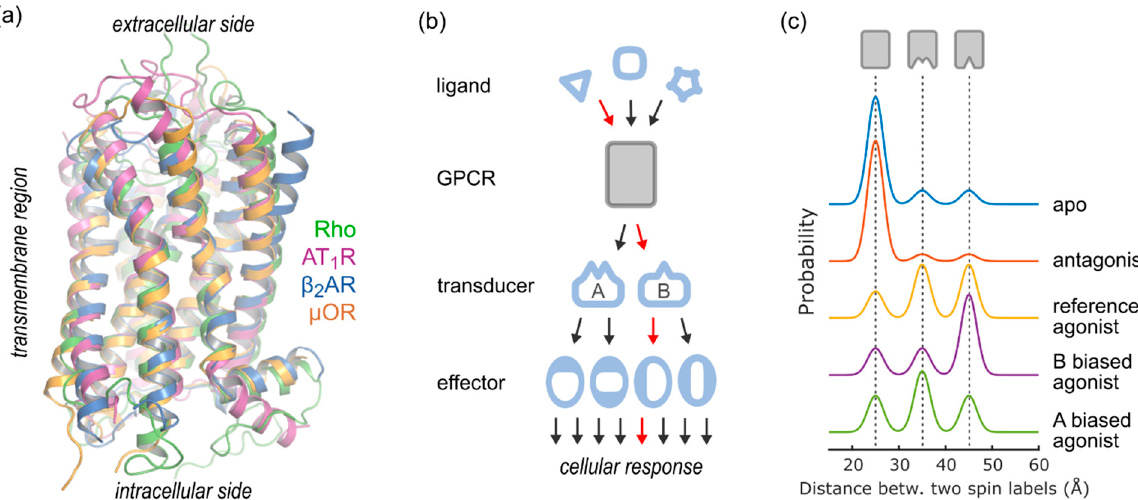
Figure 1. GPCR function seen from the DEER vantage point. ( a ) Structural homology among GPCRs of various functions. Receptor-specific ligands bind from the extracellular side, which therefore shows high structural diversity between different receptors. The transmembrane core exhibits many conserved interaction networks, suggesting a common activation mechanism. On the intracellular side, a limited set of transducer proteins (such as G protein, arrestin and GRK) bind to specific receptor conformations. ( b ) The GPCR “allosteric microprocessor”. Binding of an extracellular ligand is translated into ligand- and receptor-specific affinities and catalytic activities towards transducer proteins. Activated transducer proteins interact with different effectors and thereby elicit a ligand-specific cellular response. ( c ) Conformational selection from the DEER perspective. Different ligand classes (such as antagonists, balanced/reference and biased agonists) stabilize distinct GPCR conformations, leading to specific efficacies towards transducers. The different conformations and their populations are encoded as distance distributions derived from DEER. Note that all conformations are present even in the absence of ligand.